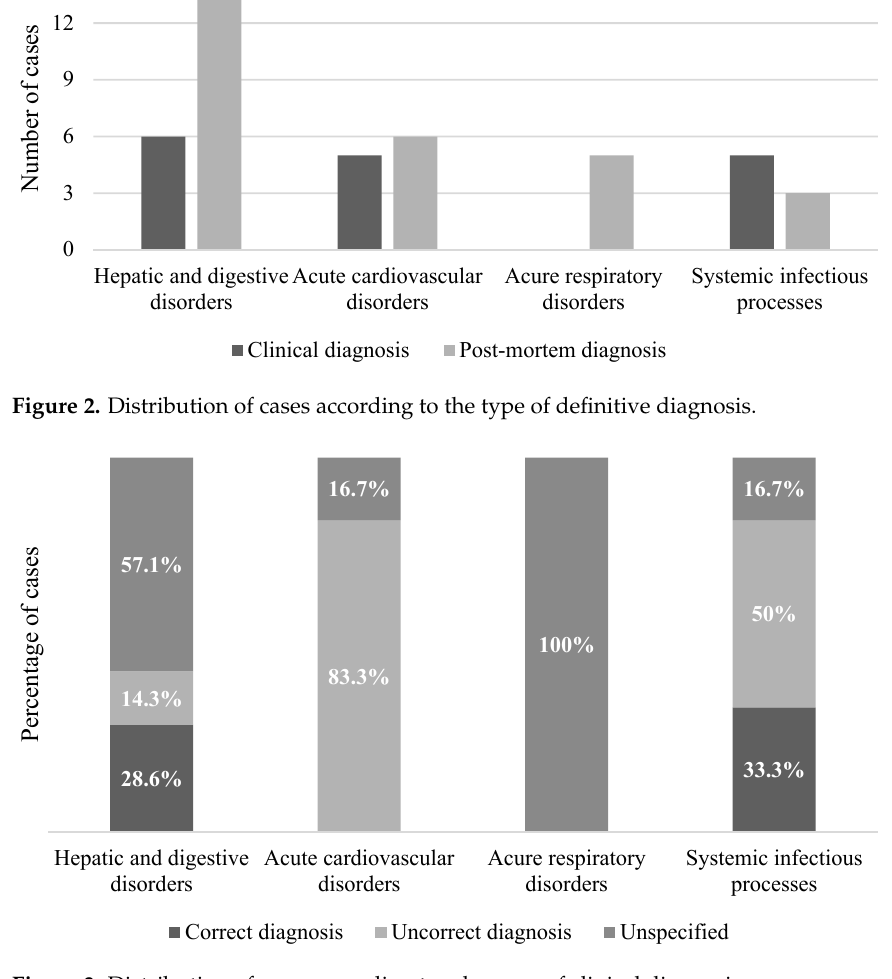
Figure 3. Distribution of cases according to adequacy of clinical diagnosis.